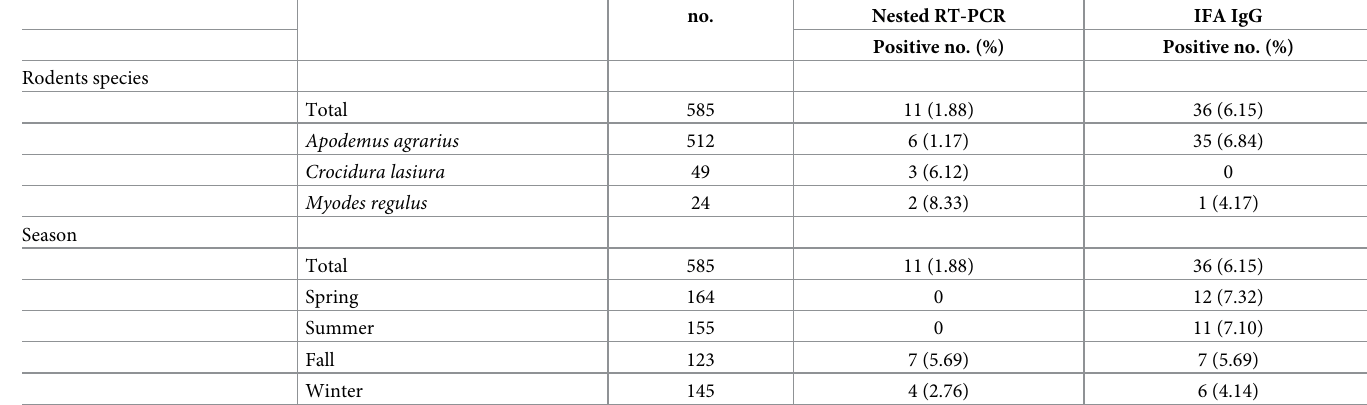
Table 3. Prevalence of hantavirus infection in wild rodents from Gwangju Metropolitan suburban areas from January 2016 to December 2018.